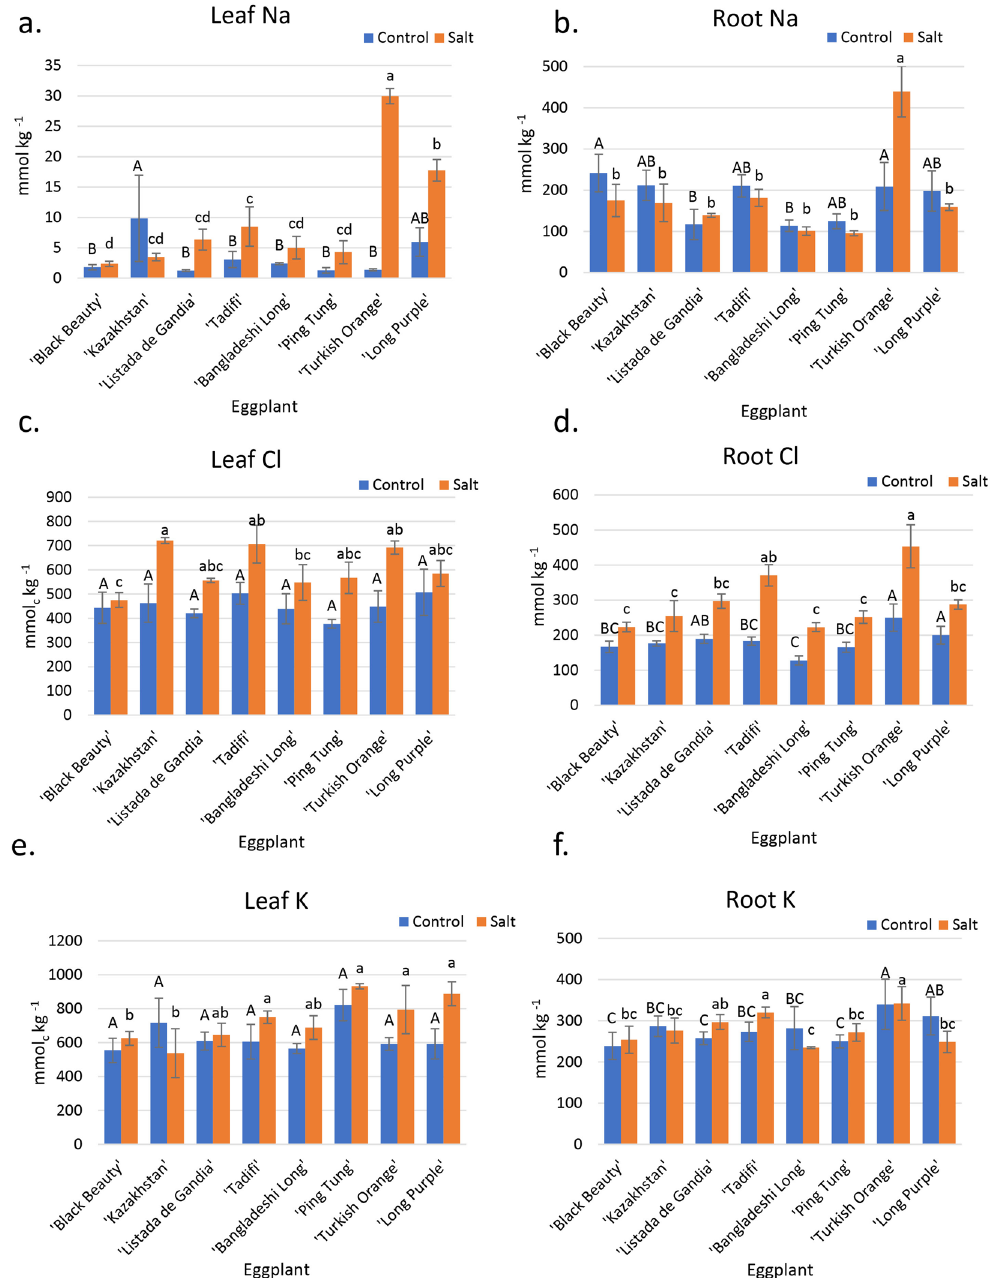
Figure 2. Tissue ion concentrations of eight eggplant cultivars irrigated with control and saline irrigation waters. ( a ) Leaf Na concentrations. ( b ) Root Na concentrations. ( c ) Leaf Cl concentrations. ( d ) Root Cl concentrations. ( e ) Leaf K concentrations. ( f ) Root K concentrations. Capital letters denote differences among cultivars under control conditions, while lowercase letters denote significant differences under saline conditions ( p < 0.05). Error bars represent standard